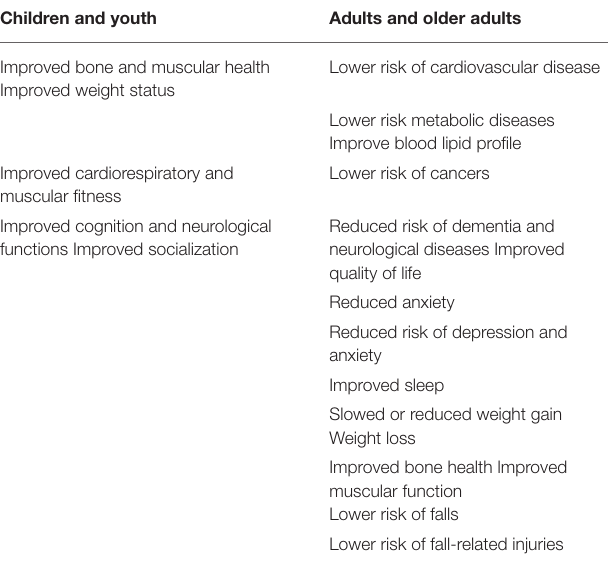
TABLE 1 | Principal physical activity benefits related to different age groups. Children and youth Adults and older adults Improved bone and muscular health Lower risk of cardiovascular Improved weight status